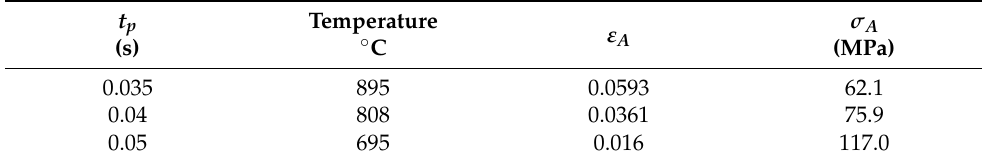
Table 4. Thermo-mechanical result at point A.